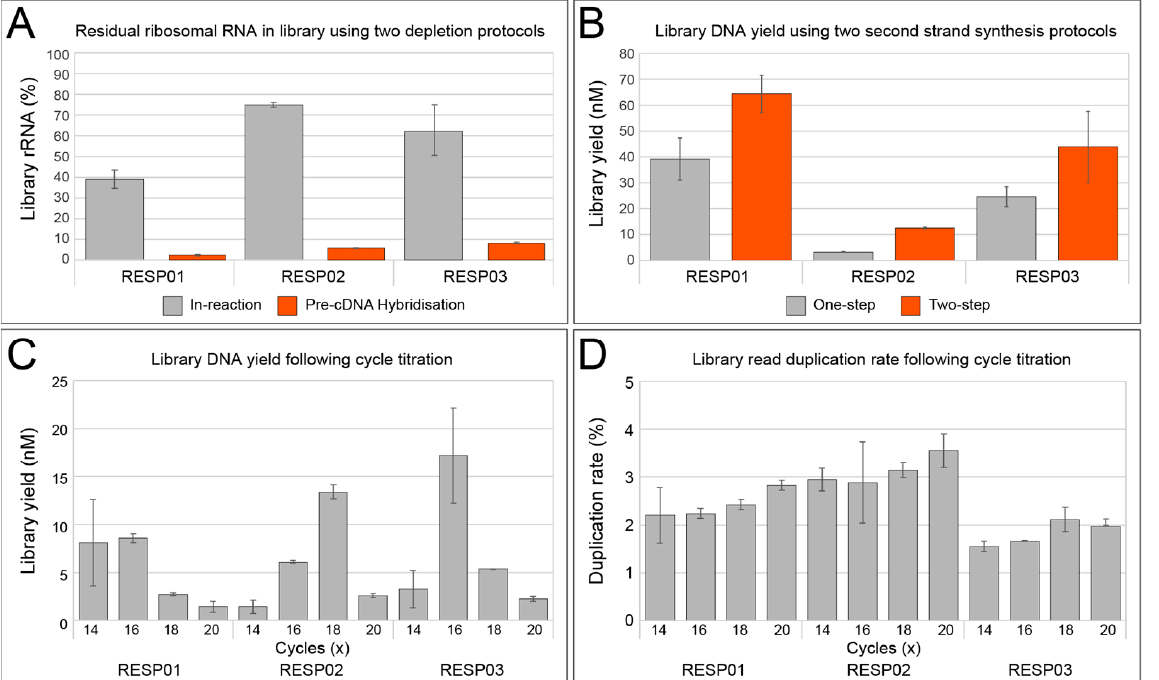
Figure 1. RAPID prep development experiments. All results here are derived from the same sample extracts (RESP01-RESP03) run in duplicate and presented as mean values and error as standard deviation (SD). ( A ) The shaded bars are representative of the percentage of residual rRNA reads in the library following rRNA depletion with either an in-reaction cDNA synthesis method (grey) or a pre-cDNA hybridization approach (orange). The bars are clustered with respect to the sample they are derived from, labeled on the X-axis. ( B ) A comparison in total library yield, in nanomolar generated using Tapestation values, following a parallel experiment with a one-step and two-step second strand synthesis step using the Sequenase enzyme. The grey and orange shaded bars are representative of the one-step and two-step protocols, respectively. ( C ) Grey-shaded bars represent the total library yield of each sample under different library amplification cycling conditions. The X-axis is marked with the number of amplification cycles and is sub-grouped by source sample. ( D ) The duplication rate of reads generated in the final libraries following cycle titration; the number of cycles for each sample is indicated on the X-axis, and is sub-grouped by source sample.